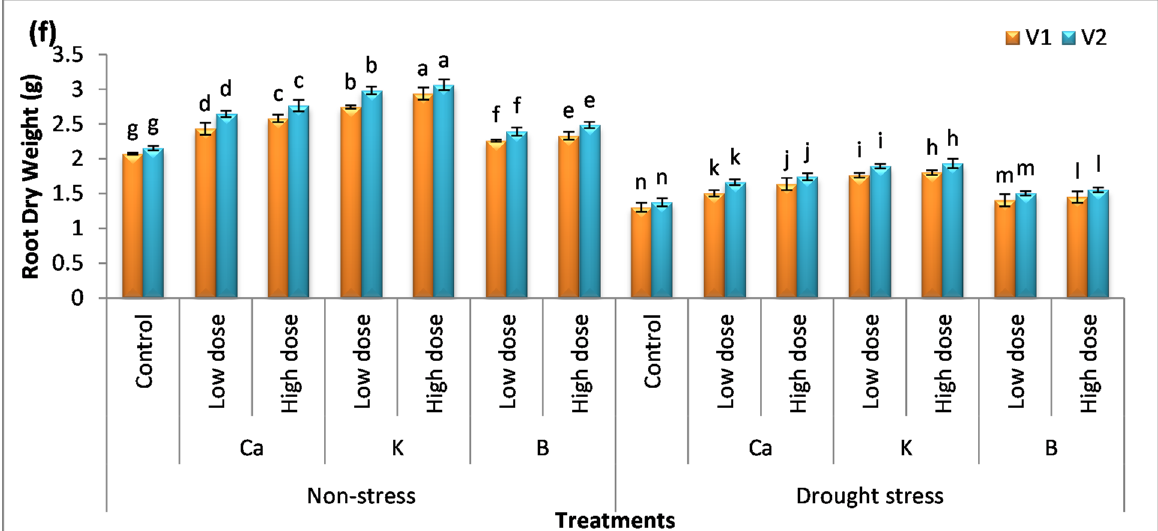
Figure 1. Effect of Ca, K, and B on growth and biomass of durum wheat. The data include ( a ) shoot length, ( b ) root length, ( c ) shoot fresh weight, ( d ) shoot dry weight, ( e ) root fresh weight, and ( f ) root dry weight of durum wheat, where V1 = Preco, and V2 = Kronos. The different letter shows significant difference among the mean values of treatments.